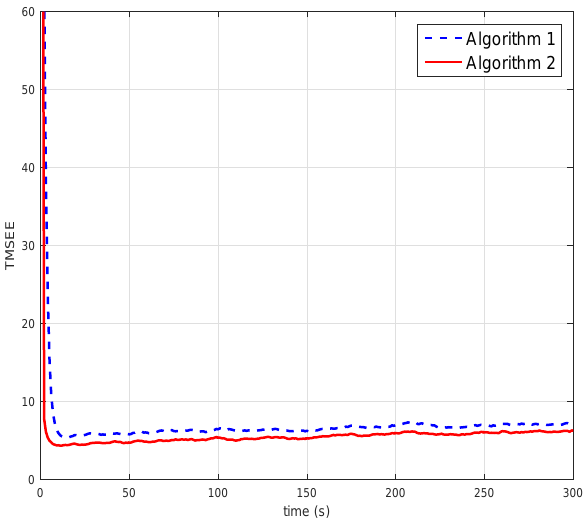
Figure 10. Comparison between algorithms 1 and 2 for case 2.